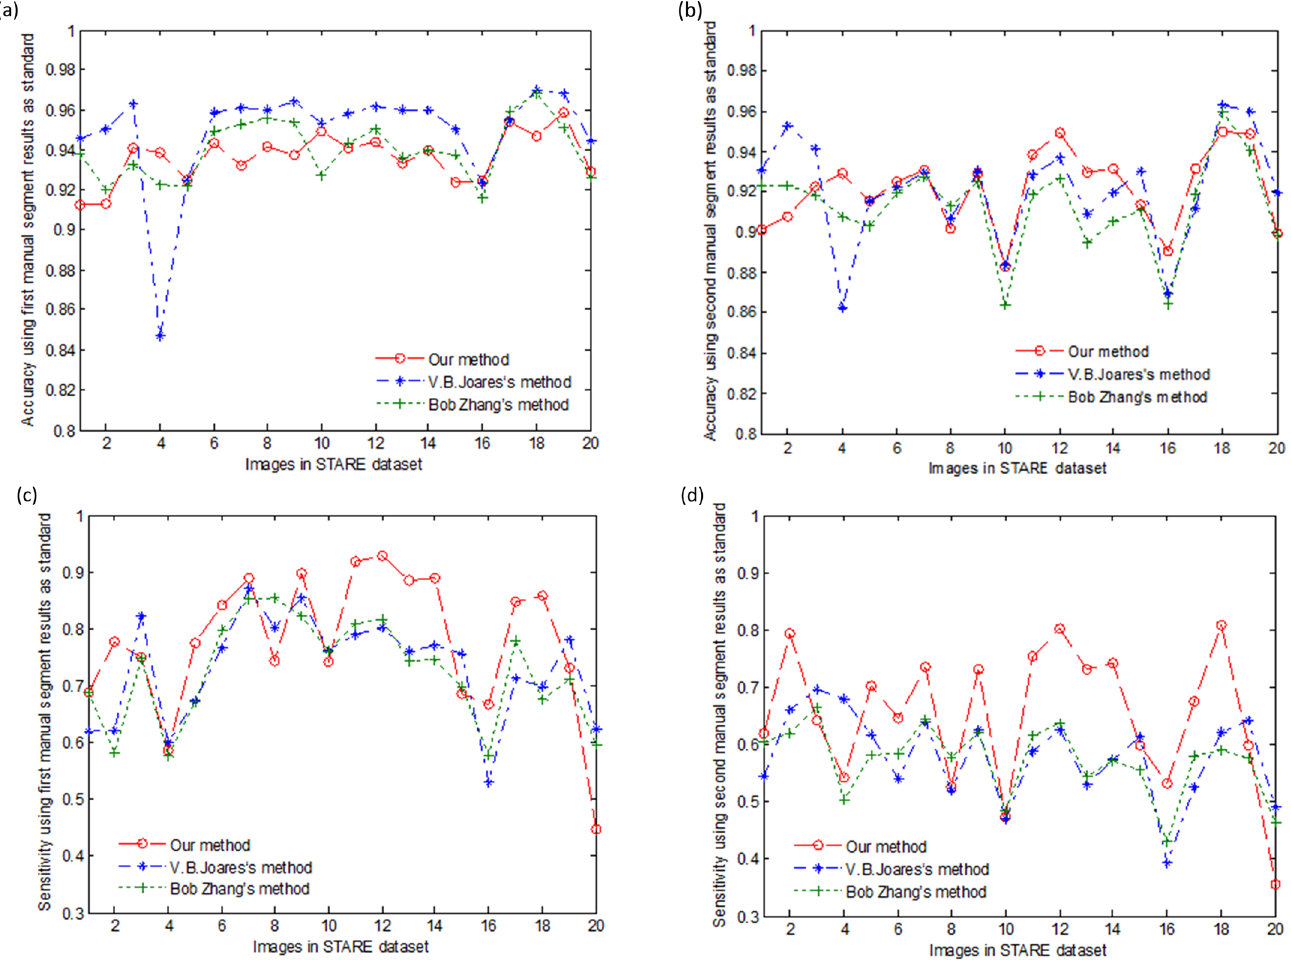
Fig 11. Accuracy and sensitivity of different algorithms with two manually segmented results from the STARE dataset: (a) the accuracy comparison of the different methods using the first manually segmented results of the STARE dataset; (b) the accuracy of the different methods using the second manually segmented results of the STARE dataset; (c) the sensitivity comparison of the different methods using the first manually segmented results of the STARE dataset; and (d) the sensitivity of the different methods using the second manually segmented results of the STARE